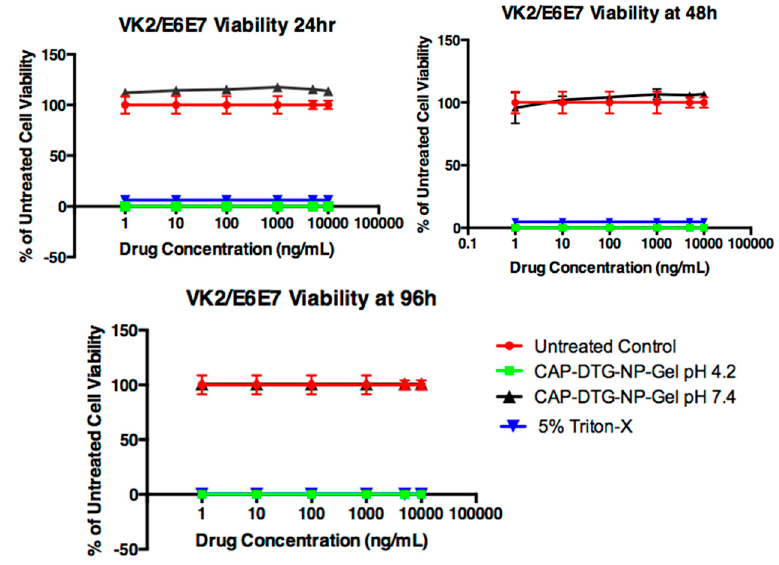
Figure 6. Vaginal epithelial VK2/E6E7 cell viability following treatment with DTG–CAP–NP–Gel at pH 7.4 ( n = 6). Error bars represent SD.